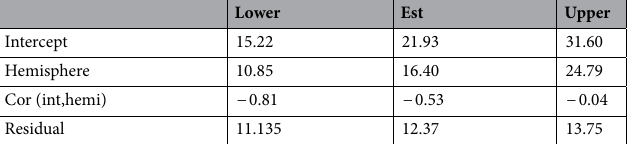
Table 2. Approximate 95% confidence intervals for the standard deviations of a random intercept, a random slope for hemisphere, and the correlation between the random intercept and the random slope, and for the standard deviation of a